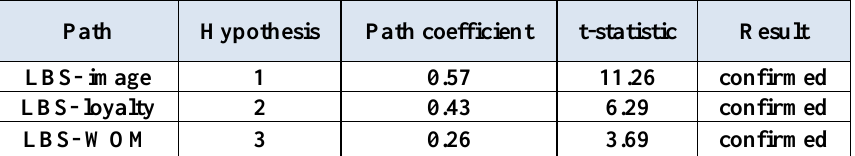
Table 7. The Results of